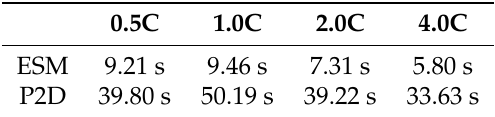
Table 1. Computational cost of simulating discharge processes at different C-rates under galvanostatic conditions, using electrochemical submodel (ESM) and pseudo-2D (P2D)